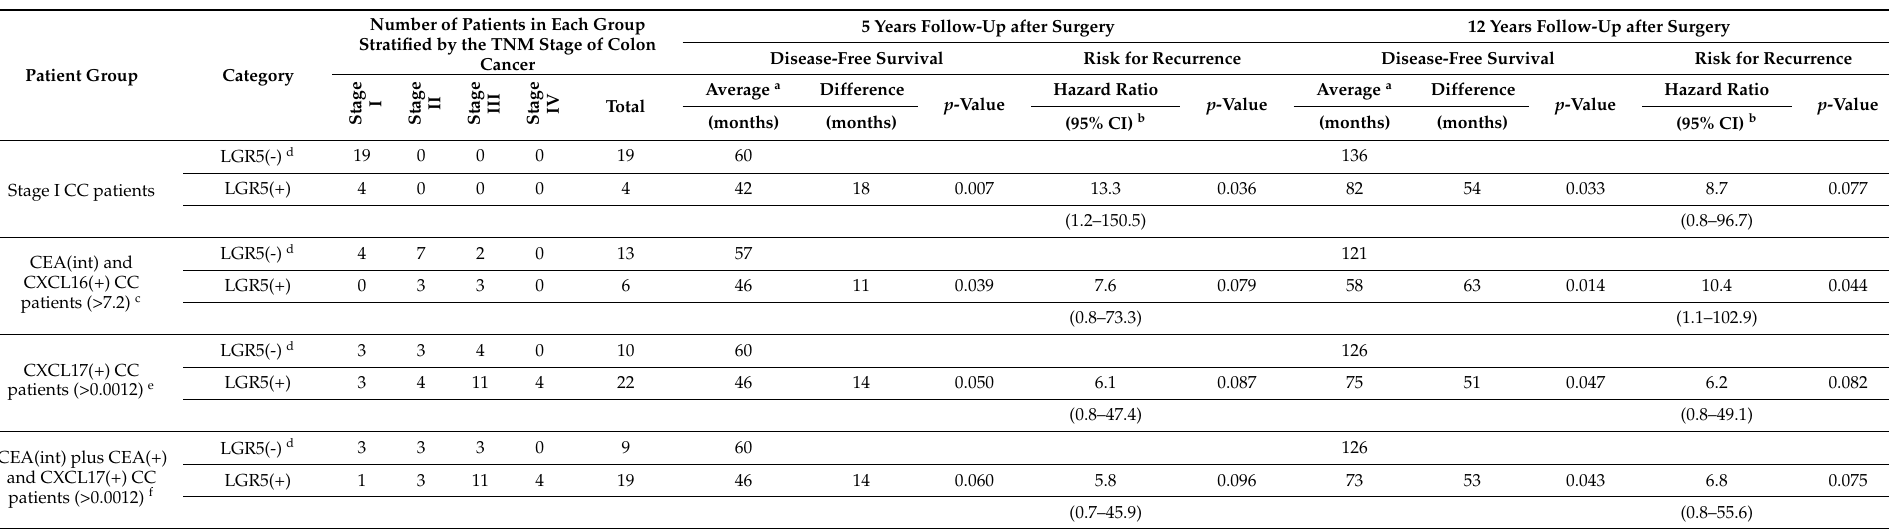
Table 3. Comparative analysis of average survival time after surgery and risk for recurrence of disease of CC patients with LGR5(-) and LGR5(+) lymph nodes when combined with other markers or restricted to a certain group of CC